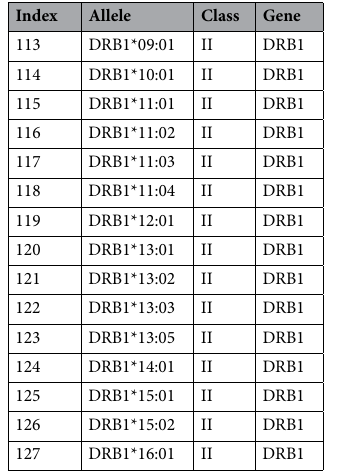
Table 2. The 127 HLA alleles used and their Class, gene assignments.